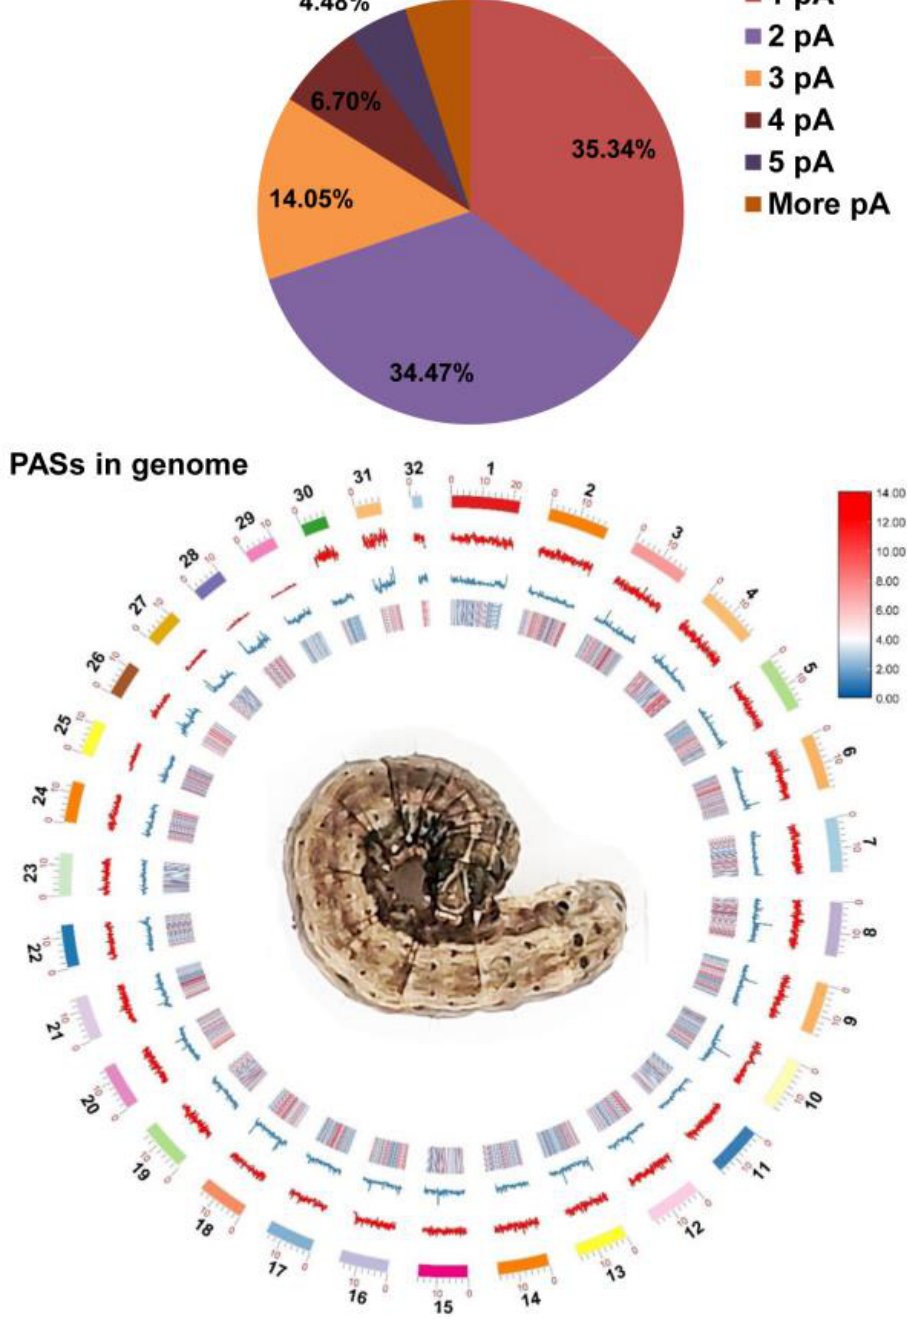
Figure 1. Identification of poly(A) sites (pA sites) in Spodoptera frugiperda . ( A ) A cluster of one or more pA sites with an inter-node separation of 20 or less nt. ( B ) The diagram shows pA site density across 32 chromosomes related to the gene, GC%, and repeat content. According to the sequence from outside to inside, the graph shows: ideogram of chromosomes in Mb, line graph of pA sites distribution, line graph of GC distribution as percentage to total bases number, gene density heat map. Red represents the highest value and blue represents the lowest